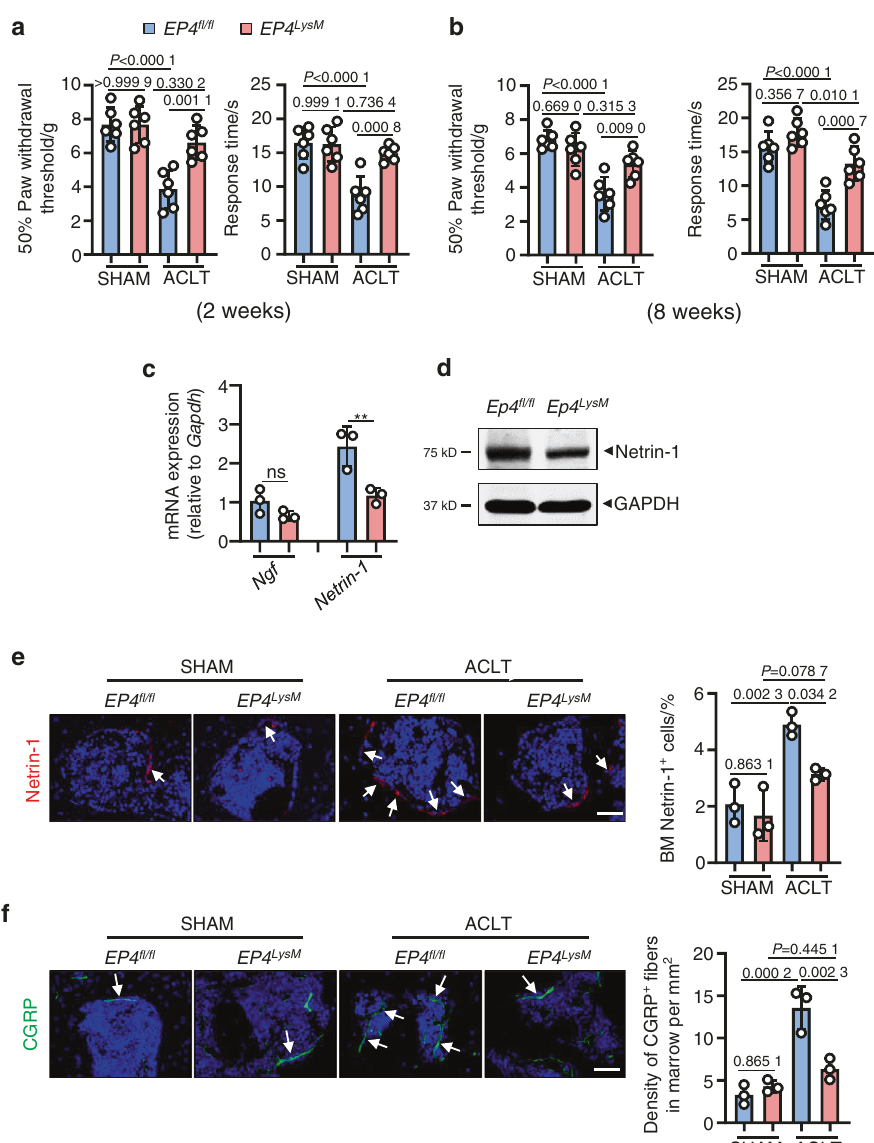
Fig. 3 EP4 deletion in osteoclasts reduces pain in OA by suppressing Netrin-1 secretion and CGRP-positive sensory neuron recruitment to subchondral bone. Von Frey assay and thermal hyperalgesia test conducted at the right hind paw of the EP4 fl / fl or littermate EP4 LysM mice 2 weeks ( a ) or 8 weeks ( b ) after ACLT surgery. Error bars are the mean ± s.d. Two-way ANOVA followed by Tukey ’ s t tests. n = 6 for each group. c qRT-PCR analysis of the mRNA levels of Ngf and Netrin-1 in osteoclasts generated from BMMs stimulated with 10 ng·mL − 1 M-CSF and 50 ng·mL − 1 RANKL and incubated with 100 nmol·L − 1 PGE2 for 5 days. The experiments were performed with three biological replicates. Error bars are the mean ± s.d. ** P < 0.01 and ns, not signi fi cant by one-way ANOVA followed by Tukey ’ s t tests. d Representative images of Netrin-1 protein by western blotting of osteoclasts generated using BMMs from the EP4 fl / fl or littermate EP4 LysM mice stimulated with 10 ng·mL − 1 M-CSF and 50 ng·mL − 1 RANKL and incubated with 100 nmol·L − 1 PGE2 for 5 days. The experiments were performed with three biological replicates. Representative images of IHF staining of Netrin-1 ( e , red) and CGRP-positive sensory nerve fi bers ( f , red) in the subchondral bone of the EP4 fl / fl or littermate EP4 LysM mice 2 weeks after ACLT surgery (left) and corresponding quantitative analysis (right). The white arrows indicate Netrin-1 or CGRP IHF signals. Error bars are the mean ± s.d. Two-way ANOVA followed by Tukey ’ s t tests. n = 3 for each group. Scale bars, 20 μ Identi fi cation of a novel potent EP4 antagonist for PGE2-induced the EP4 fl / fl mice 2 weeks post-ACLT surgery ( P < 0.01; Fig. 4d). To migration and osteoclast differentiation investigate whether this reduction in angiogenesis is mediated via To identify a potent small molecule EP4 antagonist with secreted factors by osteoclasts from EP4 LysM , we performed tube therapeutic potential in OA, we screened a class of small molecule formation assays using HUVECs treated with conditioned media compounds with 1H-1,2,3-triazole-based structures 57 , with osteo- (CM) from the EP4 LysM -derived osteoclast precursor cells. Our data show that CM from the EP4 LysM -derived osteoclast precursors clast differentiation as the primary outcome. HL-43, which refers to compound 43 in the library, was the most potent inhibitor of reduces the tube branch length and nodes compared to those of PGE2-induced osteoclast differentiation (Fig. S4a). We con fi rmed the EP4 fl / fl -derived cells ( P < 0.05; Fig. 4e). This effect was also more that HL-43 mediated its effects via EP4 by assessing osteoclast pronounced for CM collected from osteoclast precursors treated differentiation from the EP4 fl / fl - and EP4 LysM -derived cells (Fig. 5a). with PGE2 ( P < 0.001; Fig. 4e).